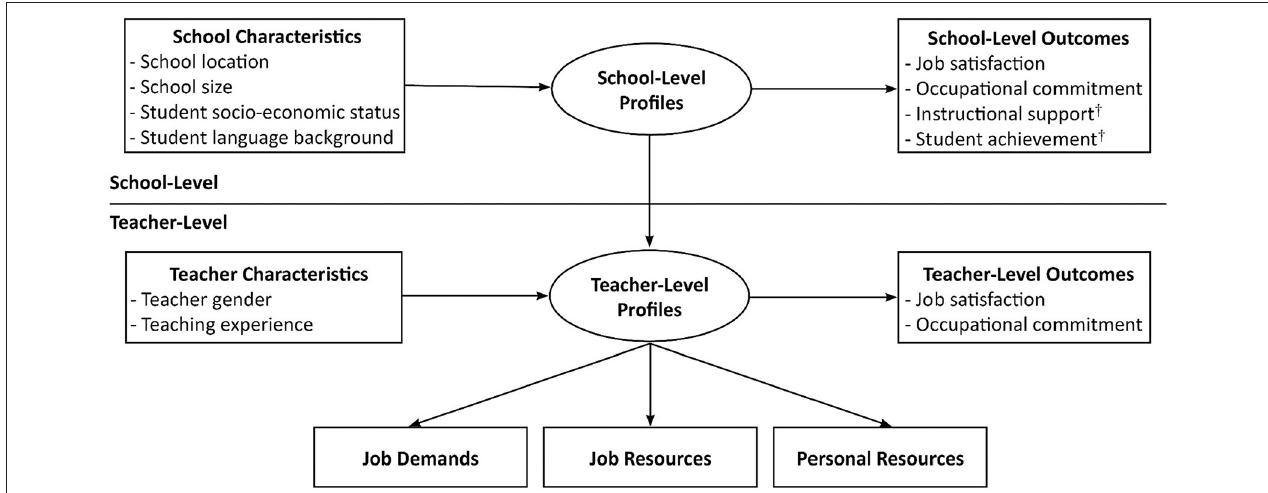
FIGURE 1 | Hypothesized models tested in the study at the teacher- and school-level. In phase one of analysis, teacher-level profiles were identified based on the demands and resources. Then, tests of associations between profile membership and predictors (teacher characteristics) and outcomes (teacher-level outcomes) were conducted. Following this, school-level profiles were identified. Then, tests of associations between profile membership and predictors (school characteristics) and outcomes (school-level outcomes) were conducted. In phase two † , analyses involved a subsample of Australian teachers who worked at schools with matched student data, and tests between profile membership and student outcomes (i.e., instructional support, student achievement) were conducted. Not shown here are the tests of profile similarity that were conducted to compare the teacher- and school-level results across countries (see Methods).